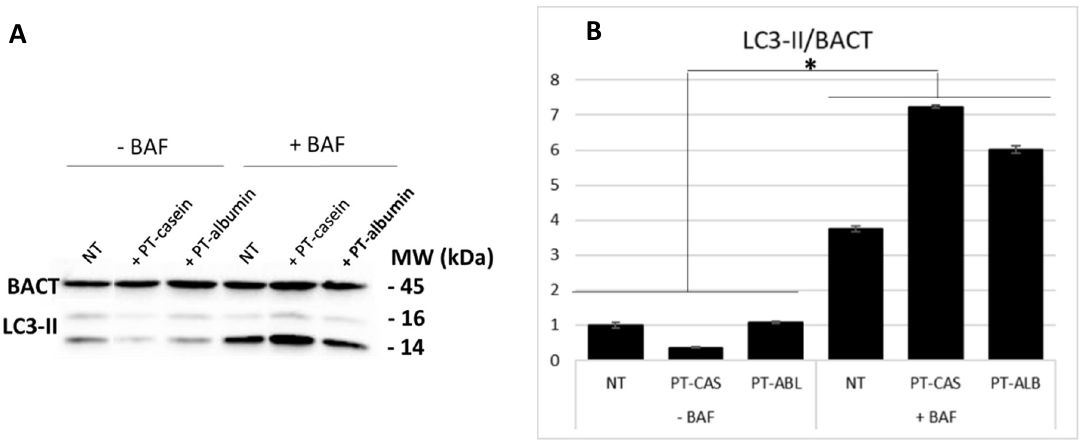
Figure 5. LC3-II levels at 24 h p.t. after PT-casein and PT-albumin administration. LC3-II protein expression was analyzed through immunoblotting ( A ) and densitometric analyses ( B ). LC3-II was normalized to BACT levels. Normalized values are reported on the y-axis as arbitrary units. Molecular weights (kDa) and SE bars are reported. The asterisks indicate p < 0.05, Anova one-way, as compared with relative controls and NT sample. The experiments were performed in duplicate.